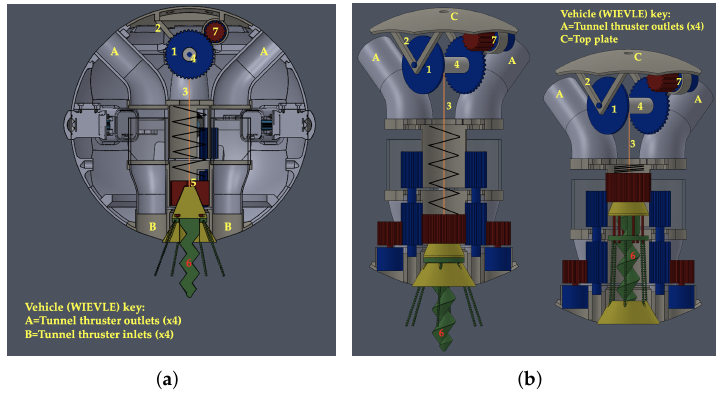
Figure 3. RAATM spool and tether assembly components: ( a ) RAATM spool and tether assembly components in the rooted position within the WIEVLE; ( b ) RAATM spool and tether assembly components in the rooted ( left ) and stowed ( right )